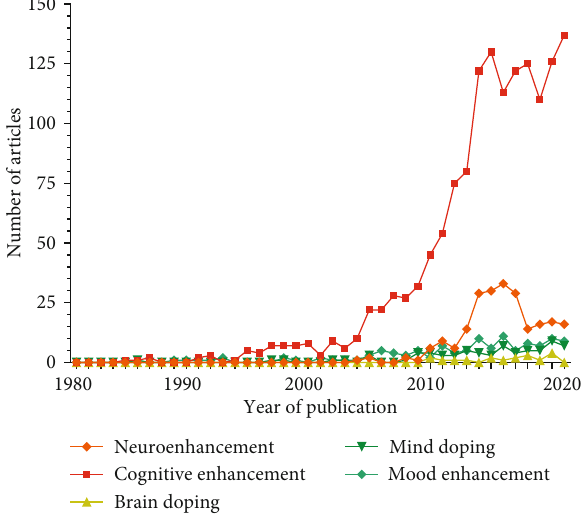
Figure 1: Annual number of publications in the fi eld of pharmacological neuroenhancement. The results of a PubMed literature search using the individual keywords “ neuroenhancement, ” “ cognitive enhancement, ” “ mood enhancement, ” “ mind doping, ” and “ brain doping ” are displayed from 1980 to 2020 (1527 publications in total). Note that there is a nearly exponential increase in the overall publication rate till 2013 which became stable within the last